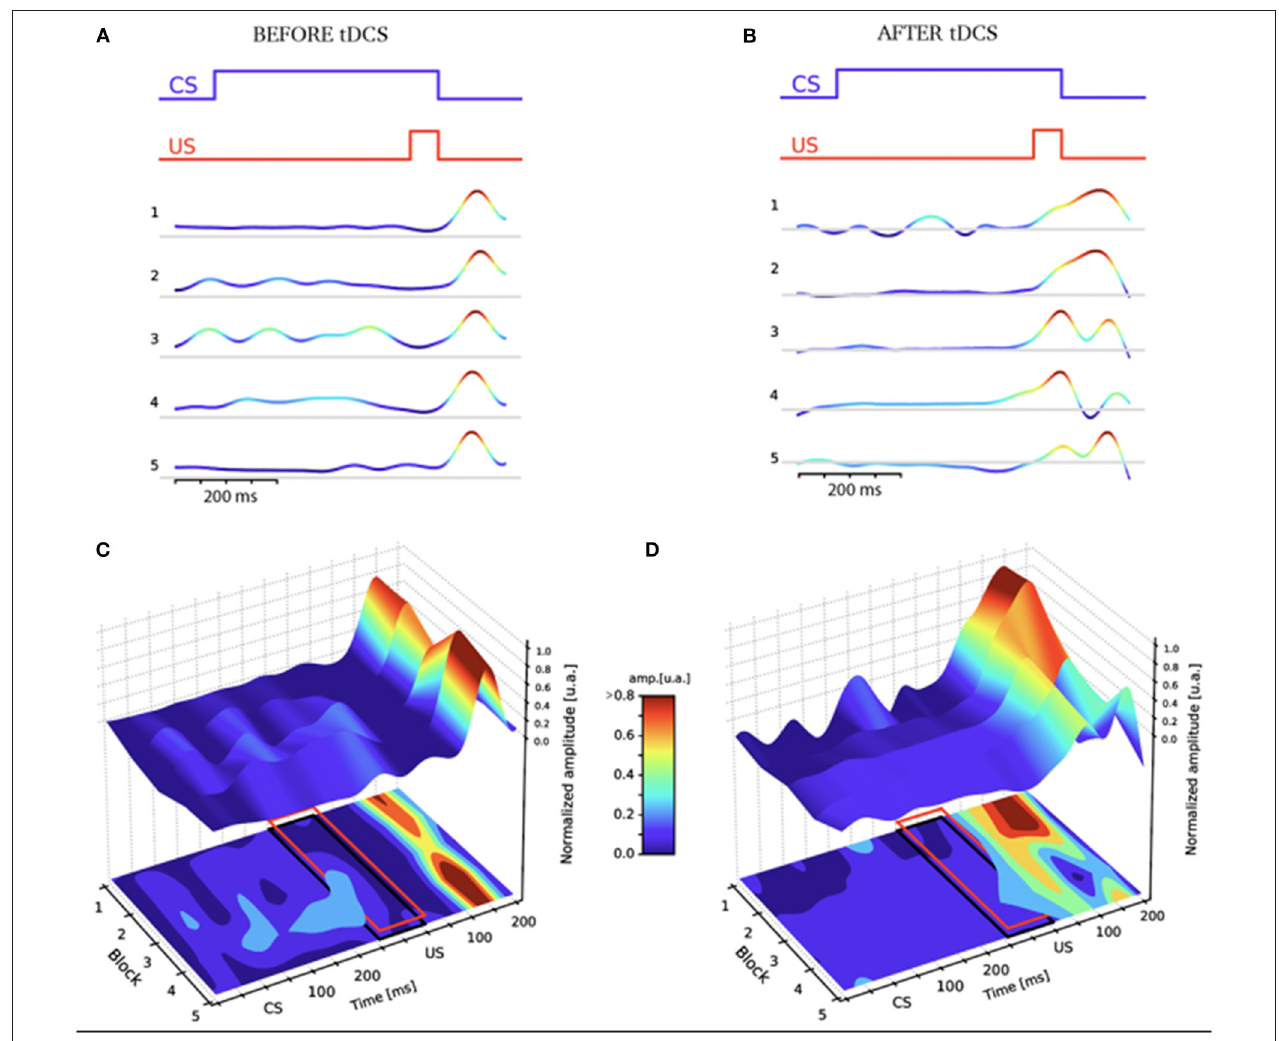
FIGURE 2 | EBC sessions before (A,C) and after (B,D) tDCS in the schizophrenic patient. The color code corresponds to the normalized response amplitude of the IR-reflected signal. The EBC protocol is depicted at the top of (A,B) . (A,B) Each block represents the average signal over the 9 CS-US trials, for experiments respectively before (A) and after (B) tDCS. (C,D) Plots of the IR-reflected signal for each block before (C) and after (D) tDCS. Red rectangles delimit the area where CRs were detected in Figure 3 left. Notice that the unconditioned response (UR) peak amplitude and latency decreases block after block after tDCS (D) , while before the tDCS the UR peak amplitude remains constant among all the blocks, and the latency shows no trend (C) .